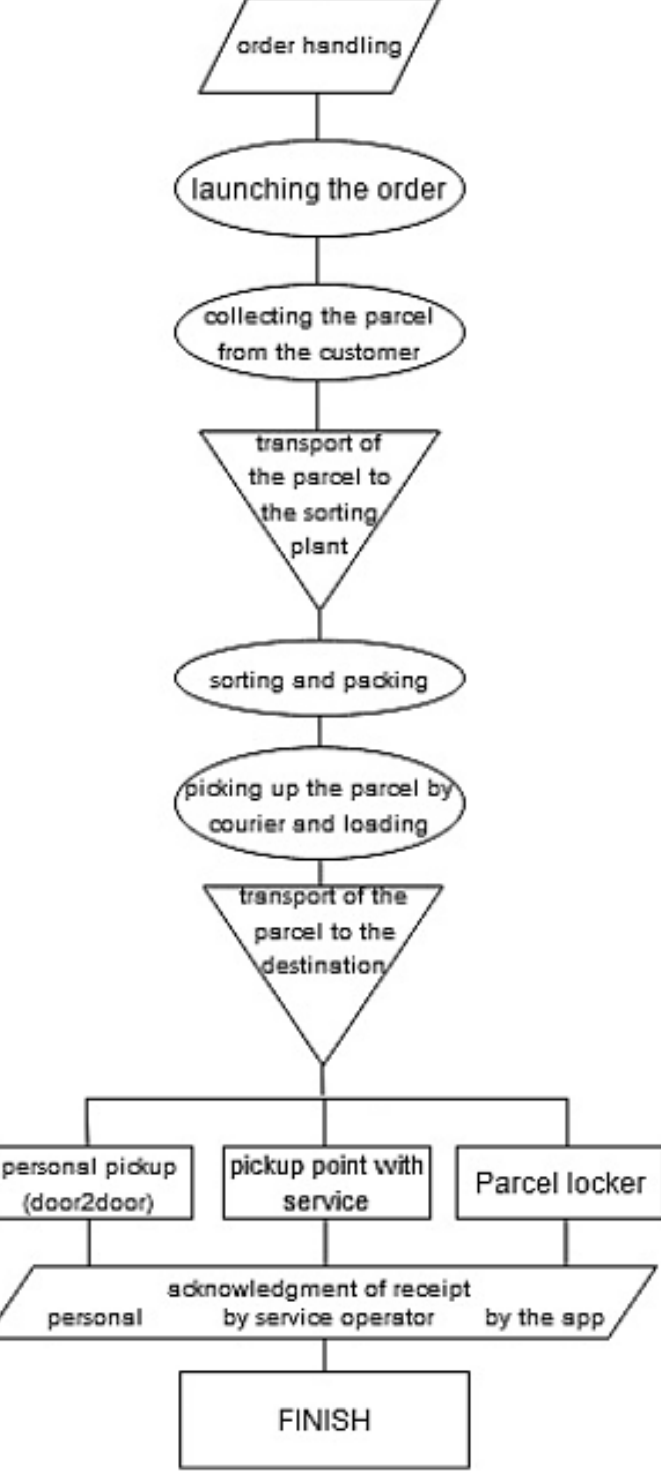
Figure 3. Courier parcel services follow an algorithm in terms of the DHI methodology.